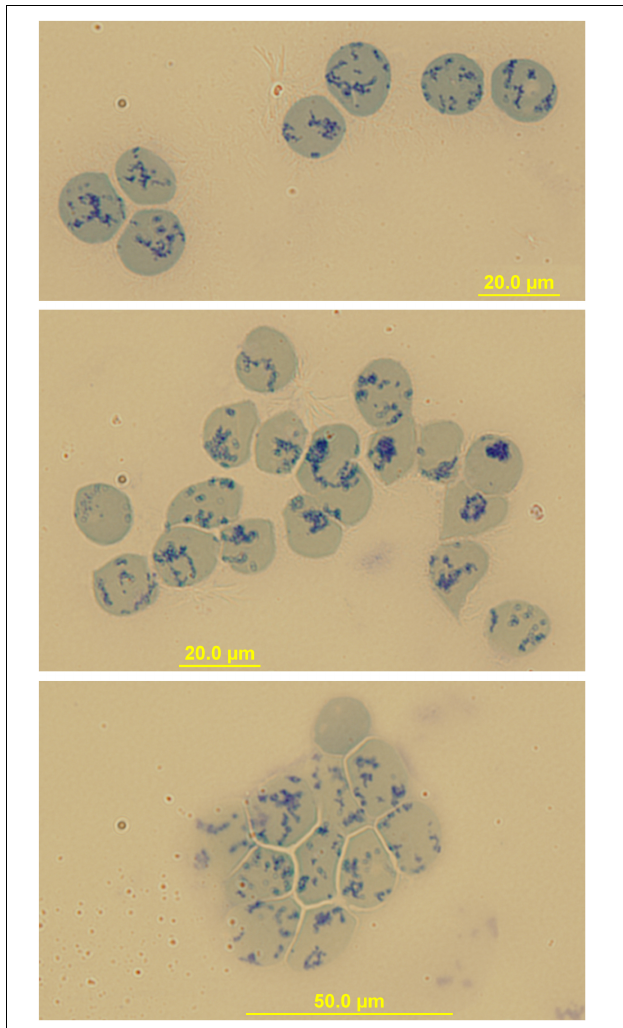
FIGURE 2 | Immunomagnetical isolation of peripheral blood Retics. Images of Retics after isolation with “CD71-microbeads” and staining with New Methylene Blue. Sometimes clumps of Retics are visible (bottom image) probably due to a crosslinking effect of the microbeads.